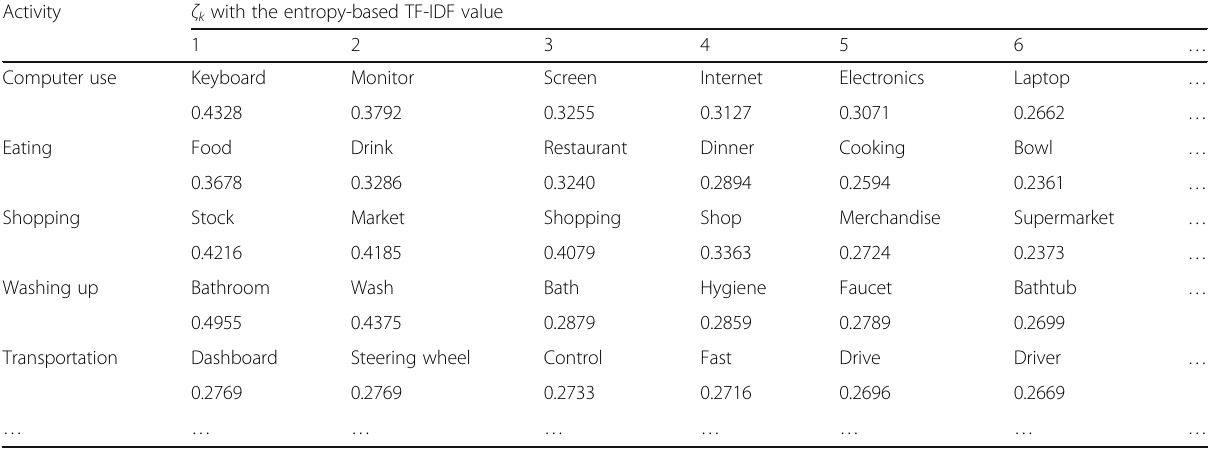
Table 4 Example of the BoT classifier